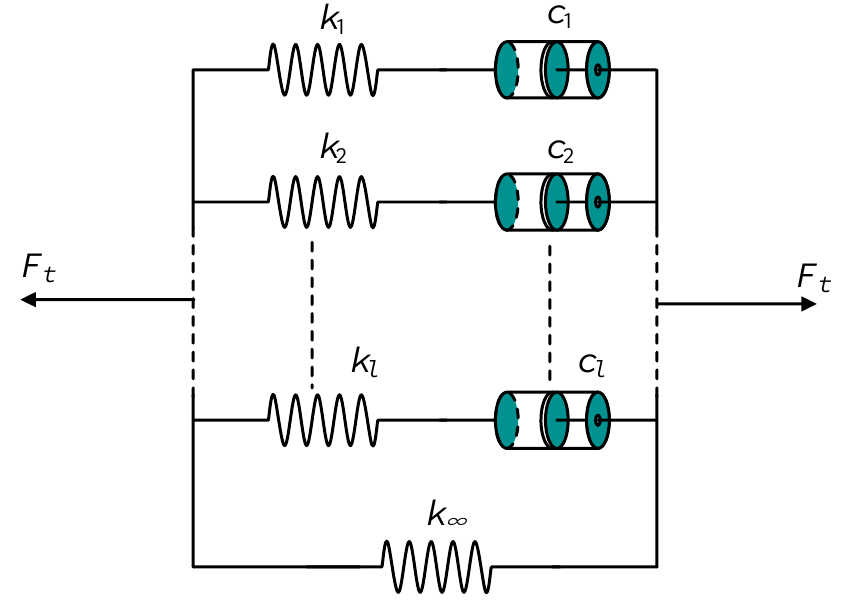
Figure 1. Mechanical model of plastic gear tooth.